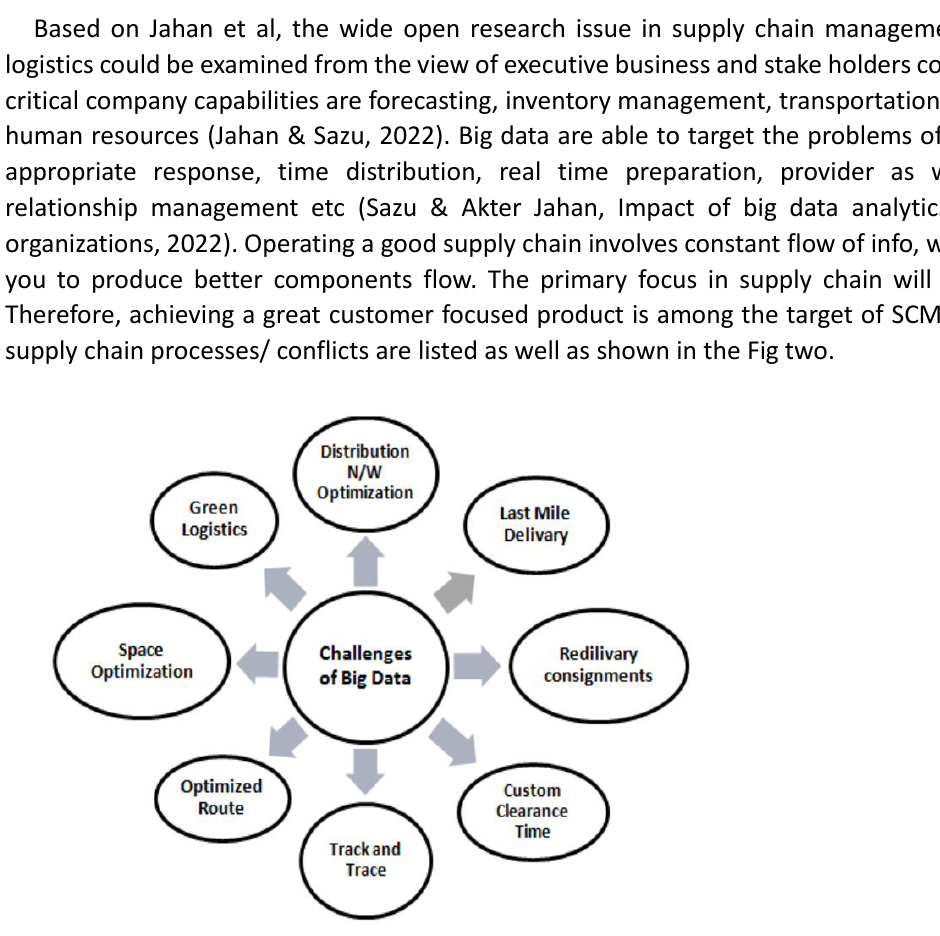
Figure 2: Big data challenges in